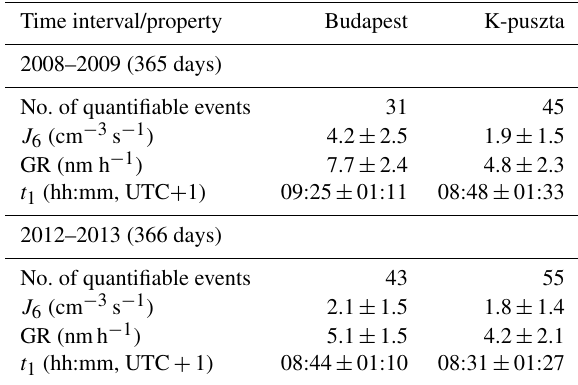
Table 3. Mean J 6 , GR and starting time parameter t 1 with standard deviations for quantifiable regional NPF events in Budapest and at the K-puszta station separately for two 1-year-long time intervals in 2008–2009 and 2012–2013. Numbers of days with quantifiable NPF events are also shown. The measurements in Budapest were performed in the city centre in 2008–2009, while they were carried out in the near-city background in 2012–2013. Time interval/property